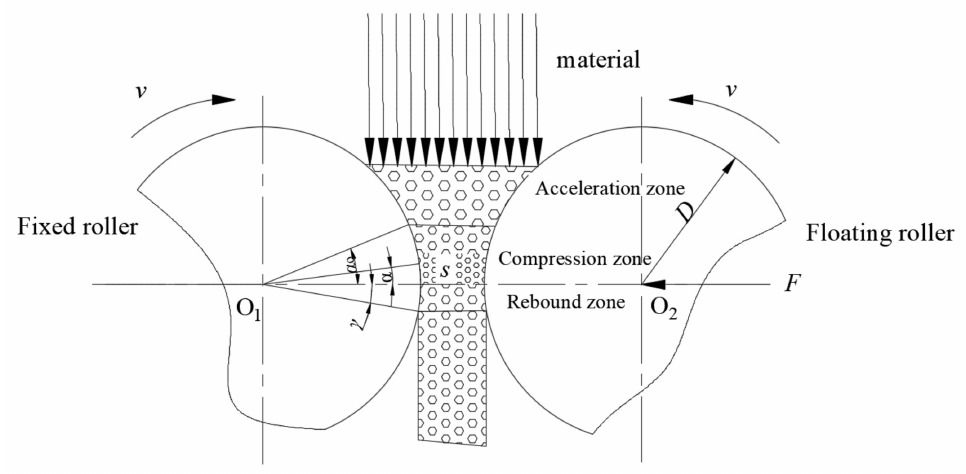
Figure 2. Working principle diagram.